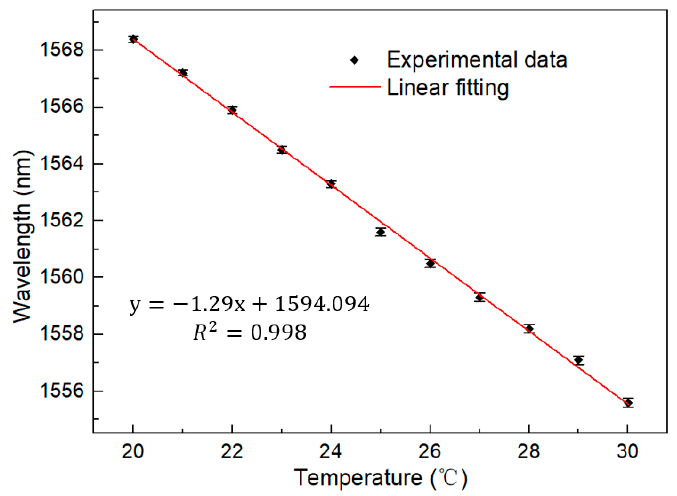
Figure 11. Linear fitting curve of laser changes with temperature (20 °C–30 °C; interval is 1 °C).